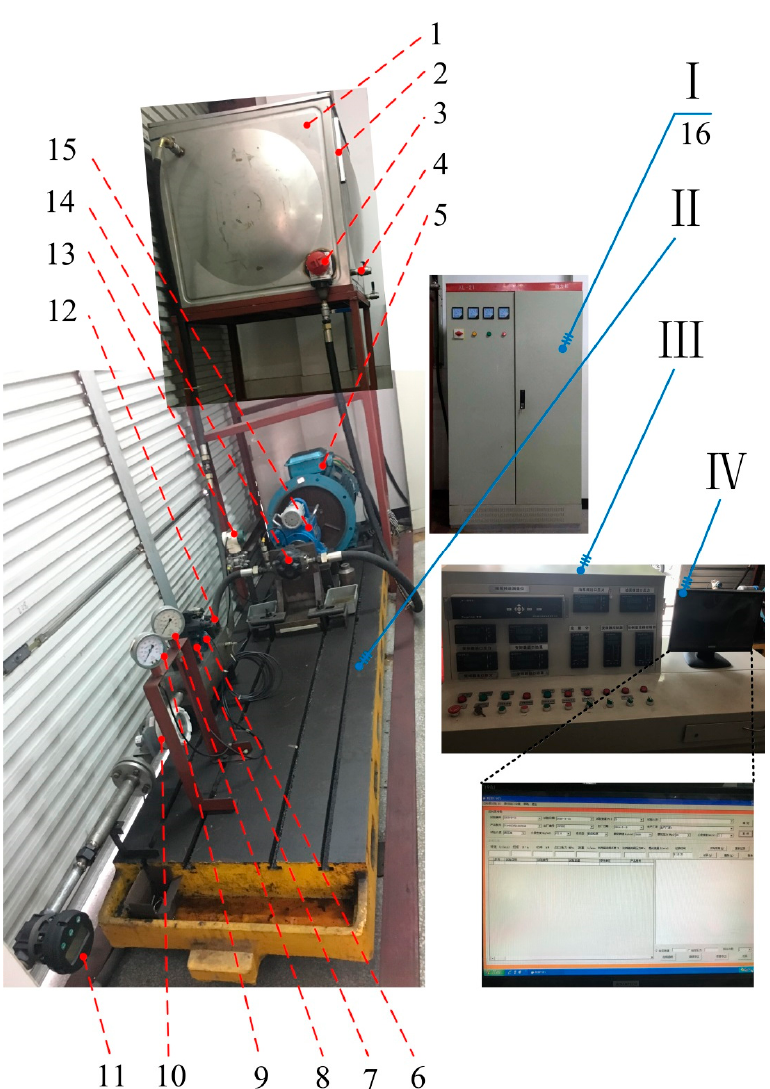
Figure 18. Overall layout of test system: Ⅰ –test bench; Ⅱ –power cabinet; Ⅲ –control cabinet; Ⅳ